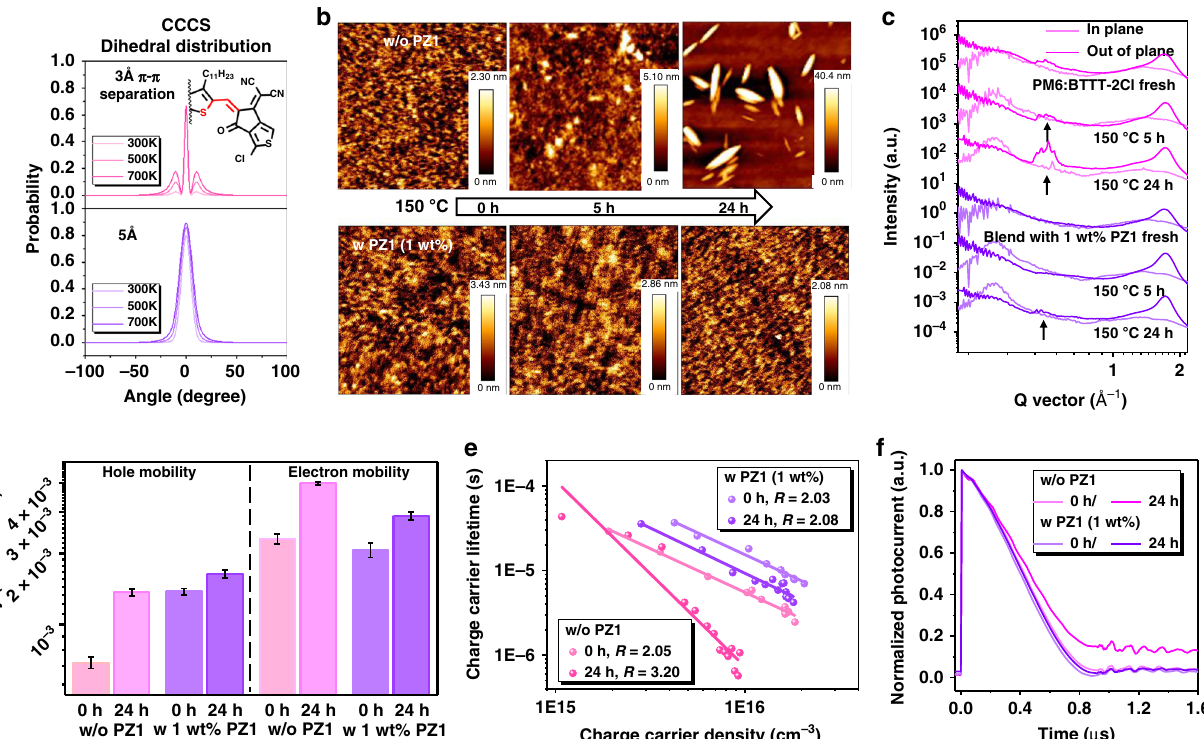
Fig. 3 Morphological characteristics and physical mechanisms of the blends. a Simulated dihedral distributions when π – π con fi nements are con fi ned to 3 and 5Å, respectively. The distribution broadens indicate the chains twisting at different temperatures. b Surface topographic AFM images (size: 5 µ m×5 µ m) of the undoped and PZ1-doped fi lms under thermal stress. c The one-dimensional GIWAXS line curves of the corresponding blends with respect to the OOP and IP directions. d The hole and electron mobilities of the corresponding fi lms as a function of heating time at 150°C. e Charge carrier lifetime obtained from TPV measurements as a function of charge carrier density ( n ) obtained from CE measurements under open-circuit conditions. f Normalized transient photocurrent (TPC) data for the undoped and PZ1-doped devices based on the relevant blends under thermal stress. Source data are provided as a Source Data fi